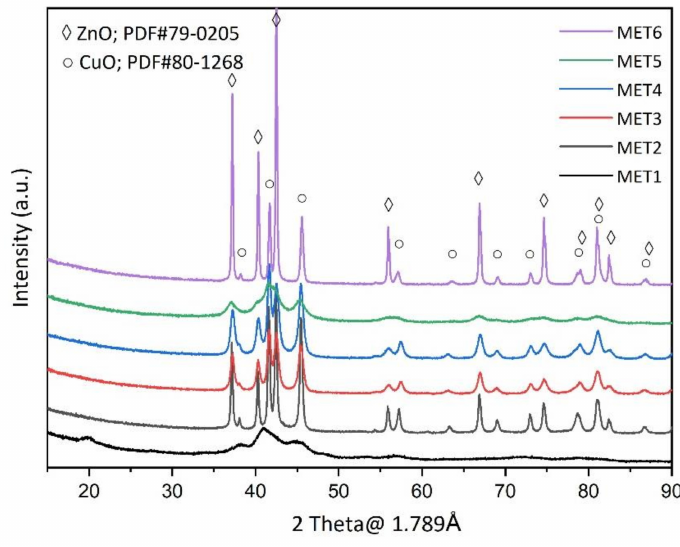
Figure 1. X—ray di ff raction (XRD) patterns of the calcined catalysts.